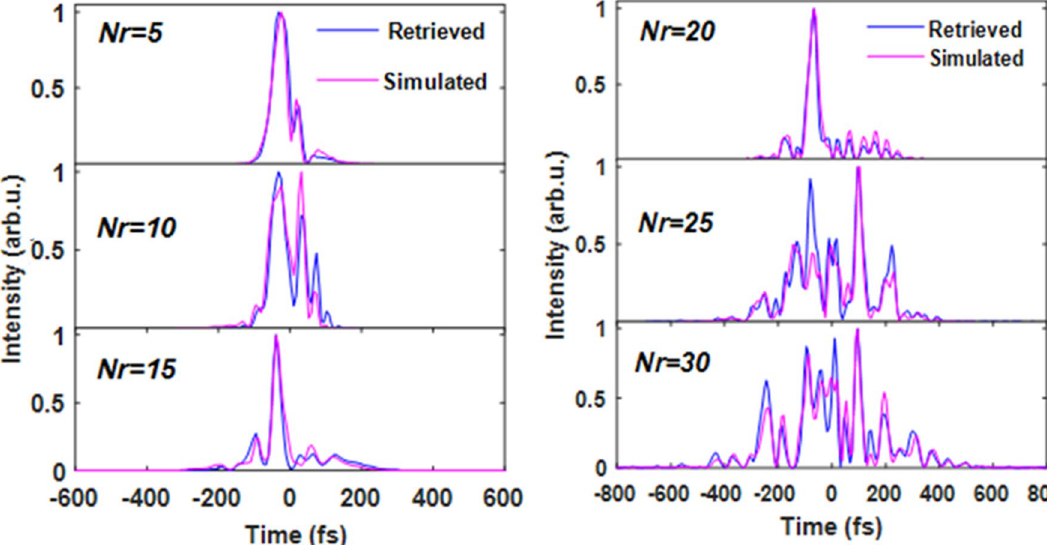
Figure 7. Experimentally retrieved (blue lines) and simulated (magenta lines) temporal intensity profiles of pulses processed with a 4f-pulse shaper with SLM-adjusted random phases N r from 5 to 30 (see text for details). The pulses were simulated by the complete